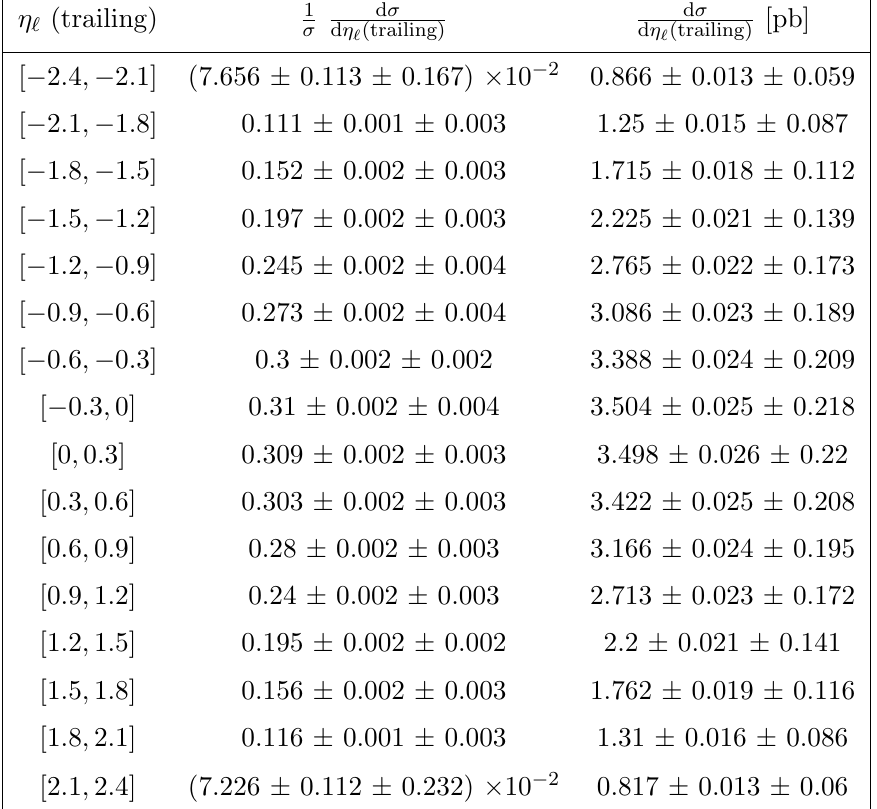
Table 36 . The measured di(cid:11)erential cross section and bin boundaries for each bin of the normalized and absolute measurements of the tt di(cid:11)erential cross section at particle level in the (cid:12)ducial phase space as a function of (cid:17) ‘ (trailing) are tabulated.